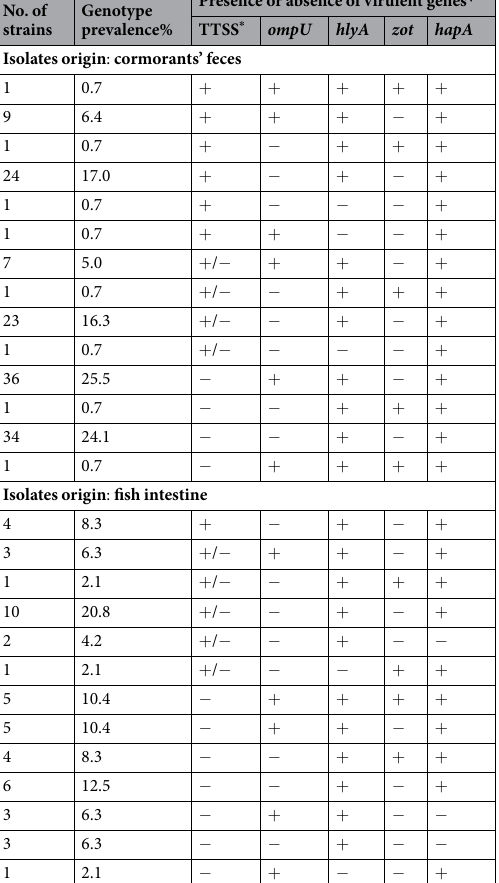
Table 3. Virulence traits of V . cholerae isolates from the cormorants’ droppings (n = 141) and fish intestines (n = 48). All the examined isolates were positive for toxR gene and negative for ctxA , tcpA and tcpI genes. * PCR- based detection of the TTSS cluster (genes; vcsC2 , vcsN2 , vspD , and vcsV2 ). ( + ) positive, ( − ) negative, ( + / − ) positive for some but not all the genes in the TTSS